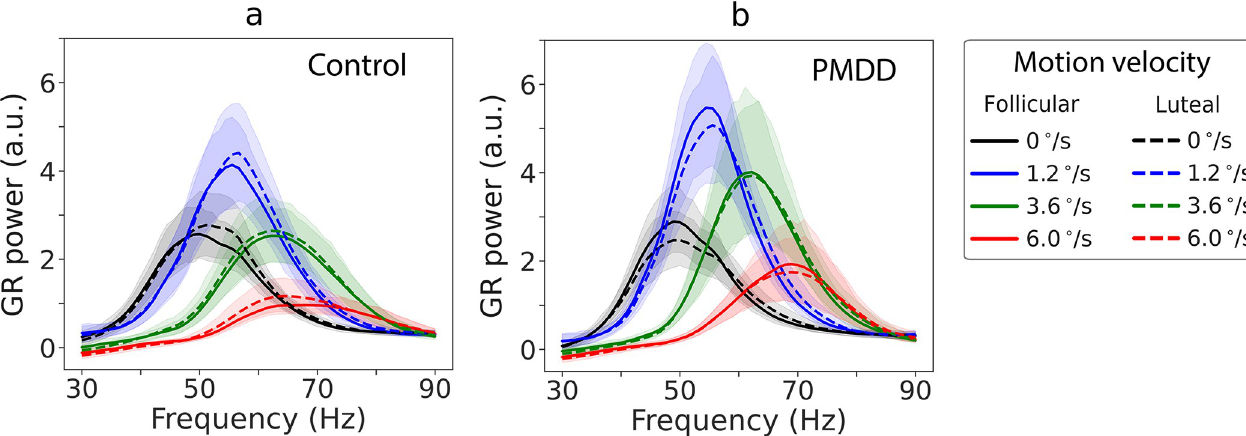
Fig 5. Grand average spectra of gamma response (GR) ([stimulation-prestimulus] / prestimulus). The spectra are shown for four motion velocity conditions (‘static’: 0˚/s, ‘slow’: 1.2˚/s, ‘medium’: 3.6˚/s, ‘fast’: 6.0˚/s), two phases of the menstrual cycle (follicular, luteal), and two groups of subjects (control (a), PMDD (b)). Shaded areas represent 95% confidence intervals.